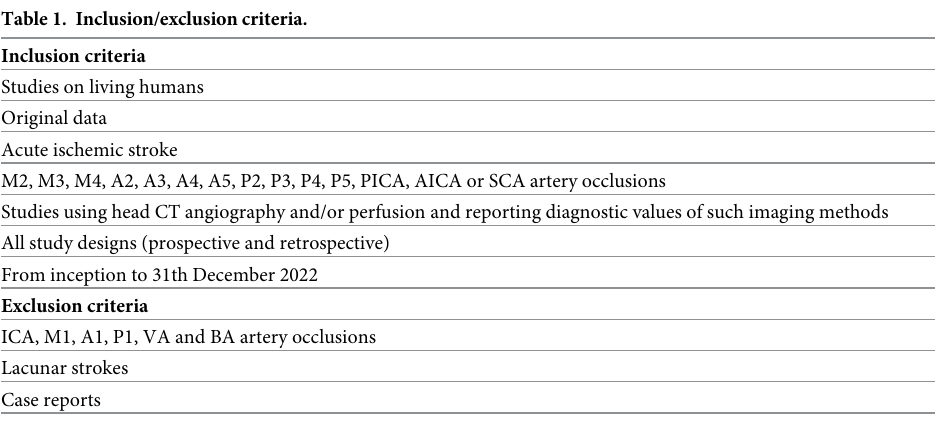
Table 1. Inclusion/exclusion